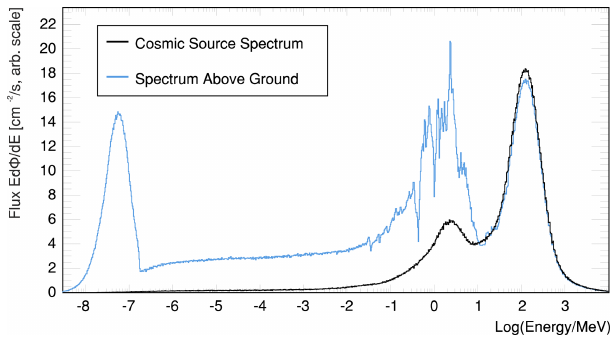
Figure 5. The URANOS cosmic neutron source spectrum (down- ward only, black) and total angular integrated flux after interaction with the soil 50m below the source